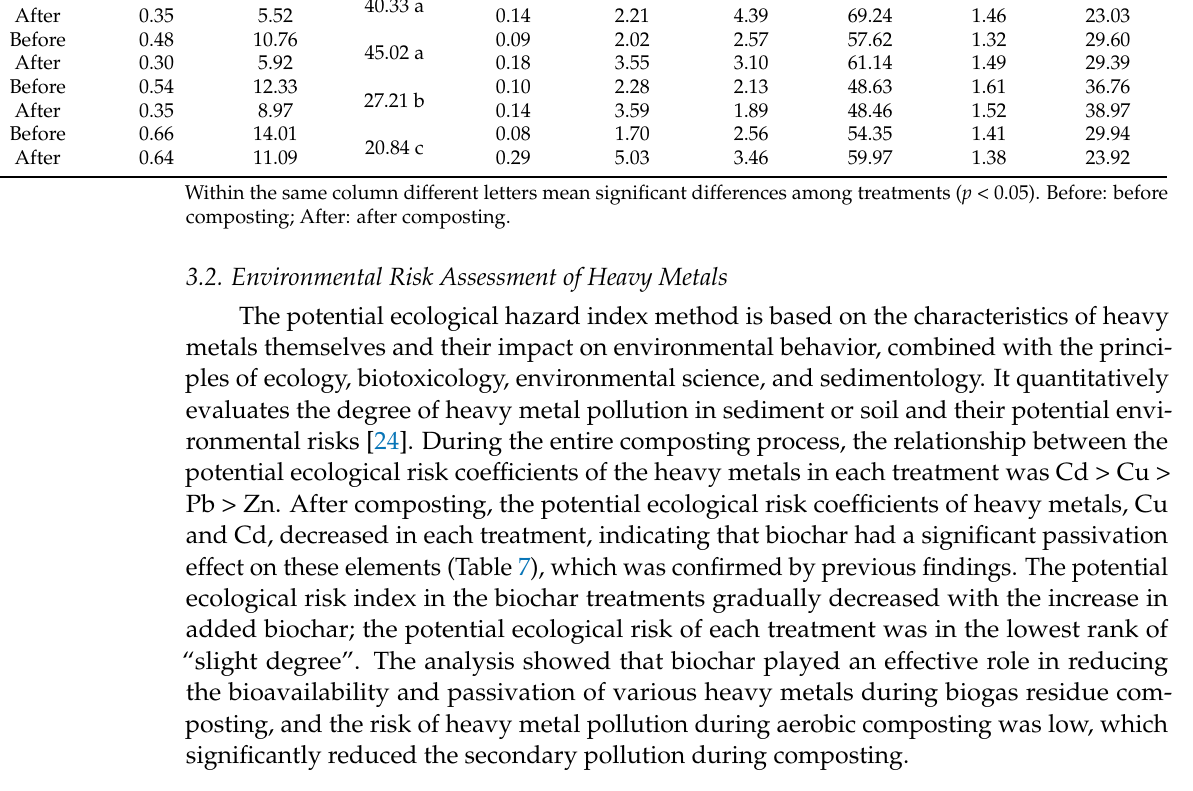
Table 7. Potential ecological risk assessment of heavy metals in biogas residue compost